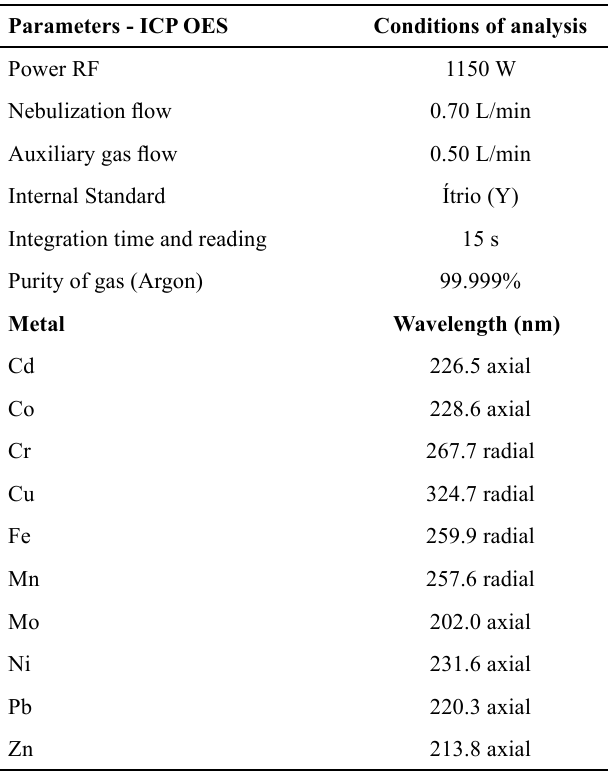
Table 2 . Conditions of analysis in ICP OES for quantification of metals in